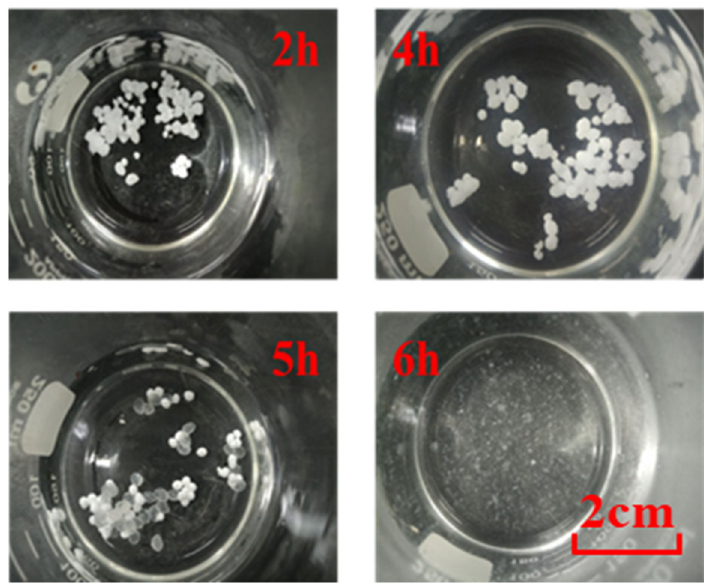
Figure 8. Degradation process of the diversion agent.